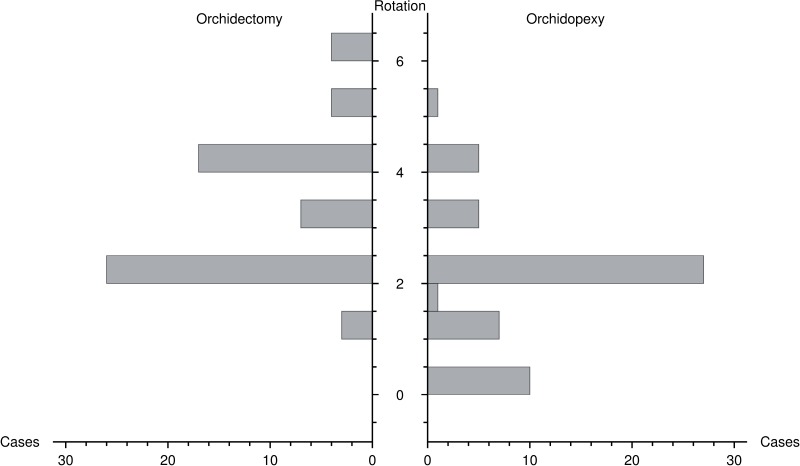
Differences in the magnitude of torsion (Rotation, in π radian) between patients either submitted to orchidectomy or orchidopexy.